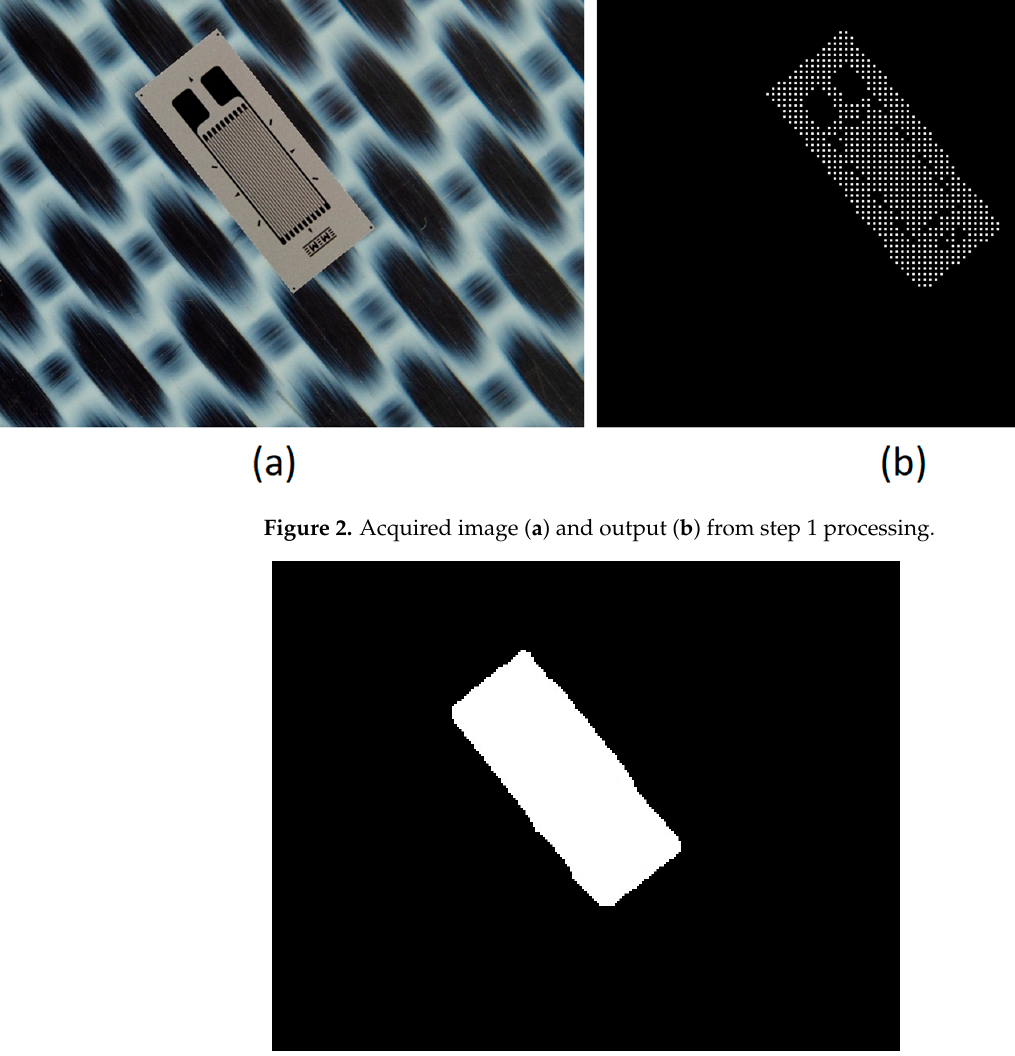
Figure 5. Result obtained after processing from step 4.